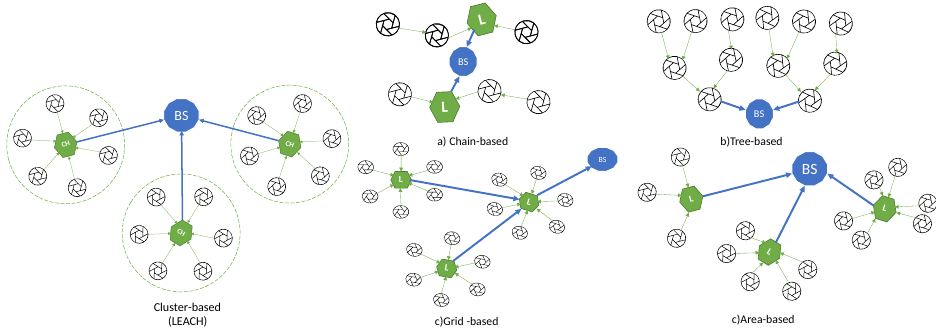
Figure 3. Different hierarchical routing strategies (BS base station, L leader, CH cluster